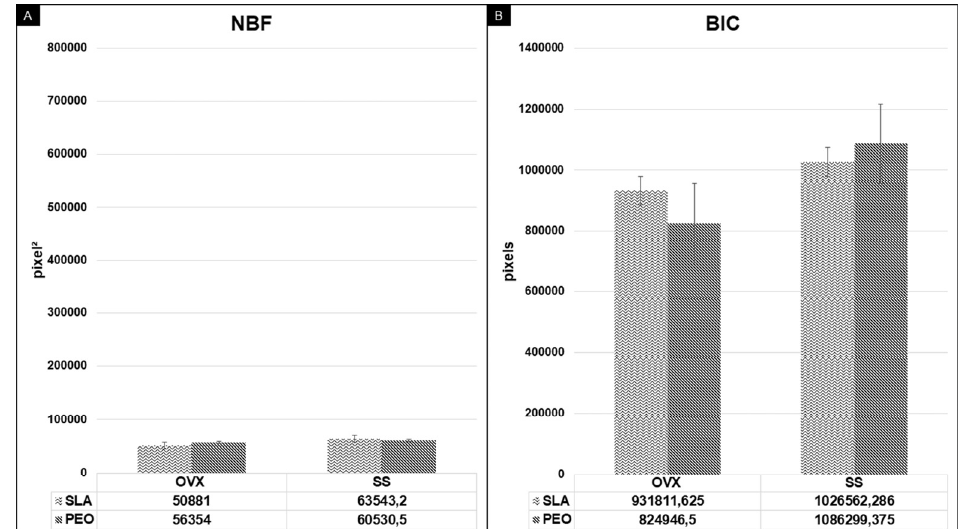
Figure 9. Histometric data measured through new bone formation (NBF) ( A ) and bone implant contact (BIC) ( B ) on bone/implant interface from experimental groups (OXV, SS) at 60 days.